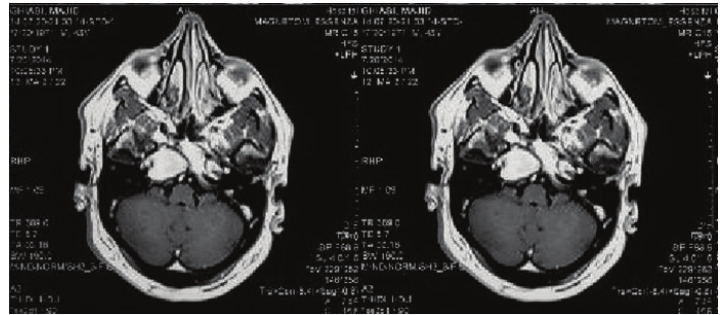
Figure 3: Axial post-GAD MRI showing the cholesterol granuloma involving the left petrous apex, adjacent to carotid artery.